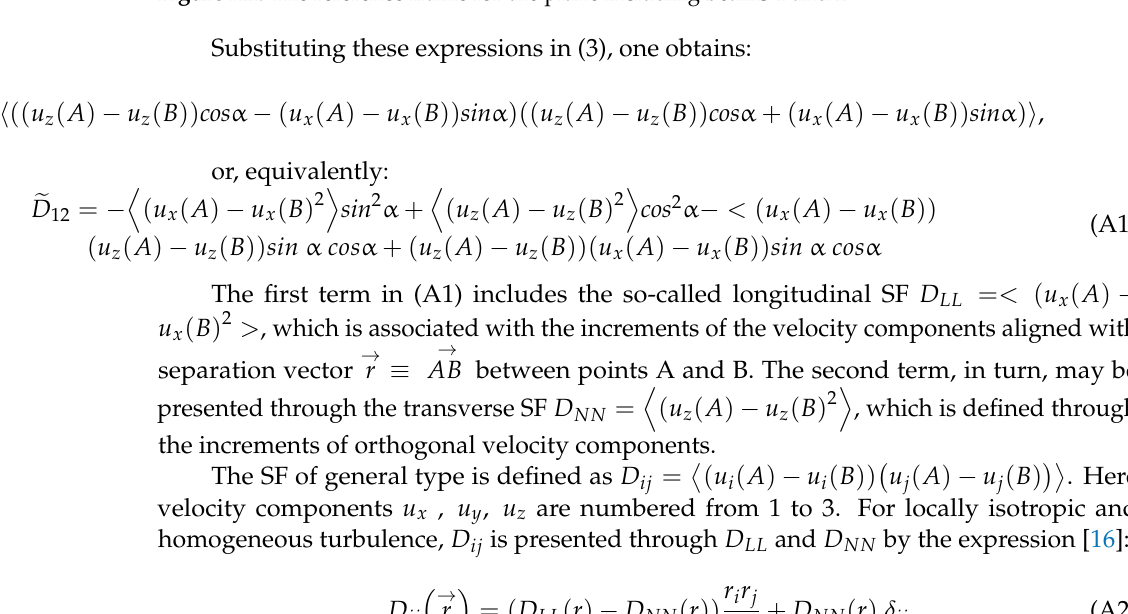
Figure A1. The reference frame for the plane including beams 1 and